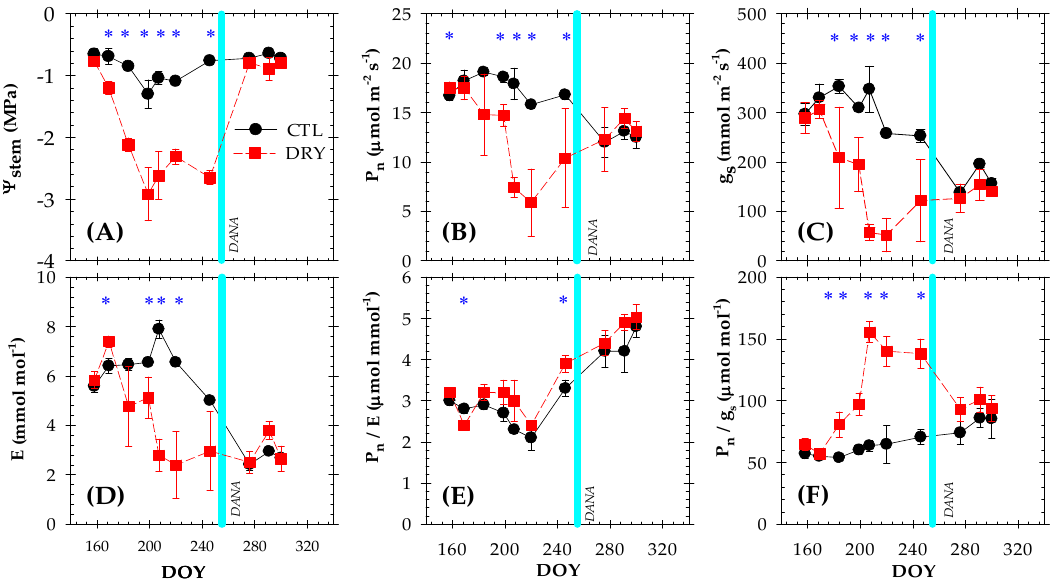
Figure (cid:561) 2. (cid:561) The (cid:561) seasonal (cid:561) variations (cid:561) of: (cid:561) ( A ) (cid:561) midday (cid:561) stem (cid:561) water (cid:561) potential (cid:561) ( (cid:794) stem ); (cid:561) ( B ) (cid:561) net (cid:561) photosynthesis (cid:561) Figure 2. The seasonal variations of: ( A ) midday stem water potential ( Ψ stem ); ( B ) net photosynthesis (P n ); ( C ) stomatal conductance (g s ); ( D ) transpiration rate; ( E ) intrinsic water-use efficiency (P n /g s ); and ( F ) instantaneous water-use efficiency (P n /E) during the postharvest period (June to November) in the CTL (full-irrigated) and DRY (non-irrigated) treatments. Each point is the mean ± standard error ( n = 4). The solid vertical cyan line indicates the DANA event. Asterisks indicate statistically significant differences according to LSD 0.05